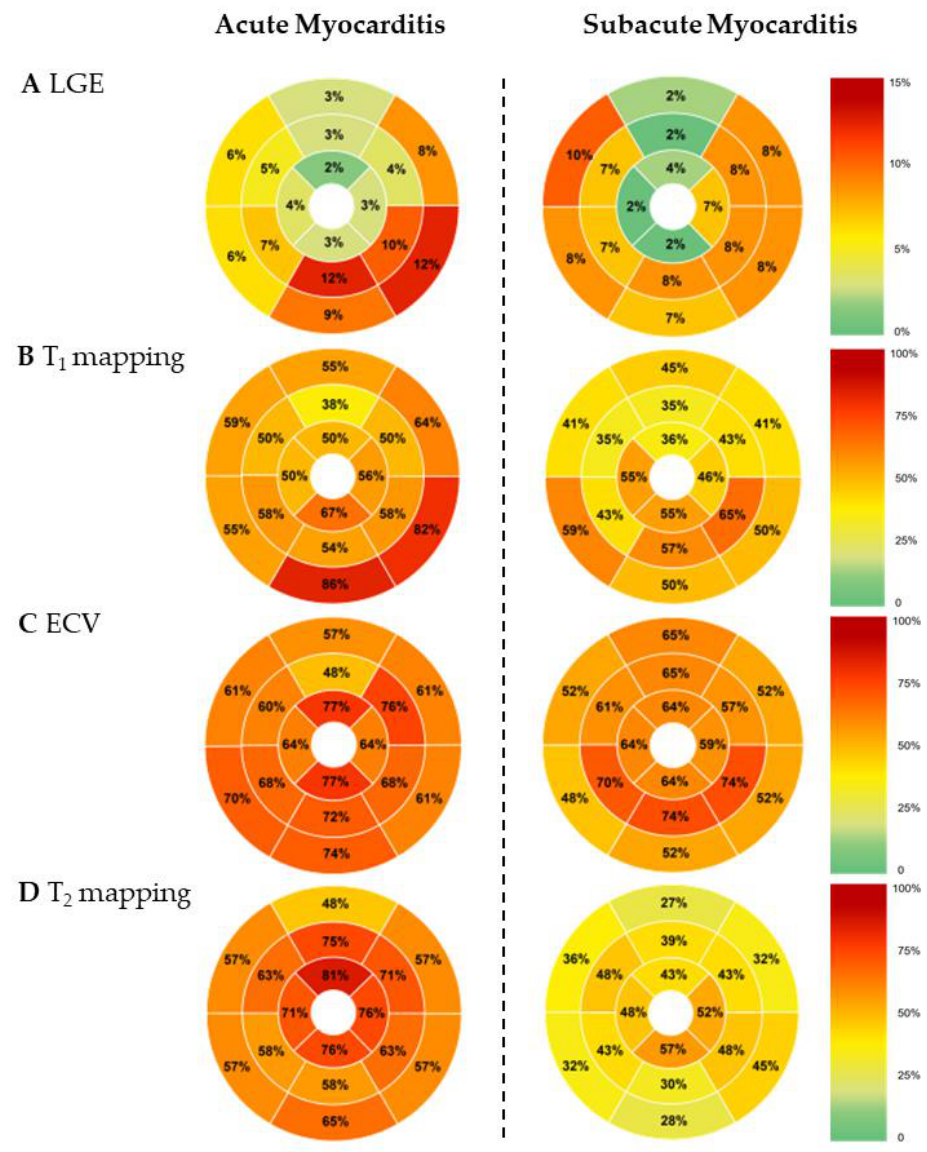
Figure 3. Location of LGE and Elevated Mapping Parameters per AHA Segments. Heatmapped 17-segment-model schemes (according to the American Heart Association) illustrate the percentage frequency of the occurrence of ( A ) LGE, ( B ) elevated T 1 , ( C ) elevated extracellular volume fraction (ECV) and ( D ) elevated T 2 .